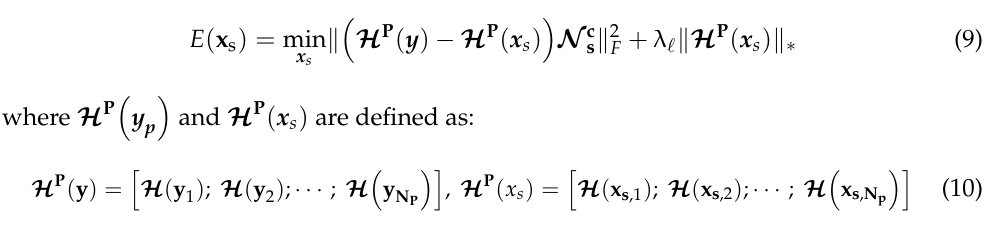
Figure 2. Utility of low rank in Hankel structured matrix. The larger Hankel matrices, which combine all parameter k -space data, are more rank-deficient than single and composite slices, which implies that the matrix completion scheme is more suitable to the application of MR parameter mapping.